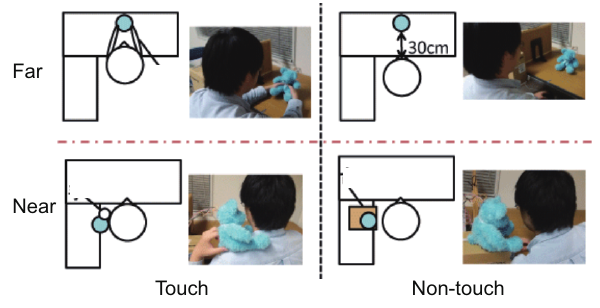
Figure 1: Experimental